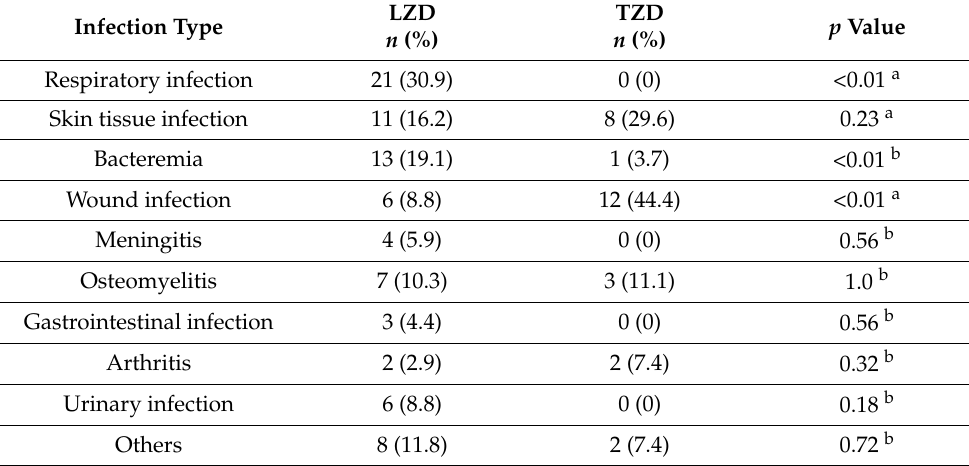
Table 2. Proportion of patients based on the infection